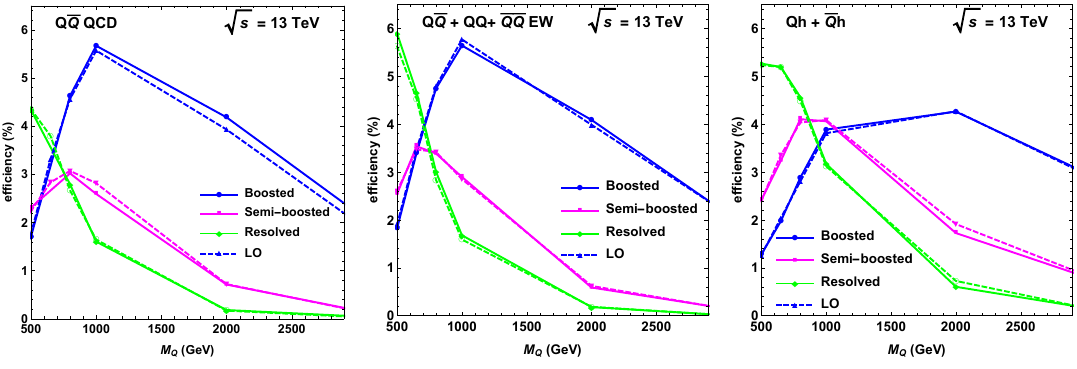
Figure 12 . Signal selection e(cid:14)ciencies as a function of the VLQ mass for the boosted (blue), semi-boosted (magenta) and resolved (green) analysis categories and separated in terms of the di(cid:11)erent components of the signal, namely QCD (left panel) and EW (middle panel) VLQ-induced production and Qh (right panel) production. The solid lines refer to NLO simulations while the dashed lines refer to a LO